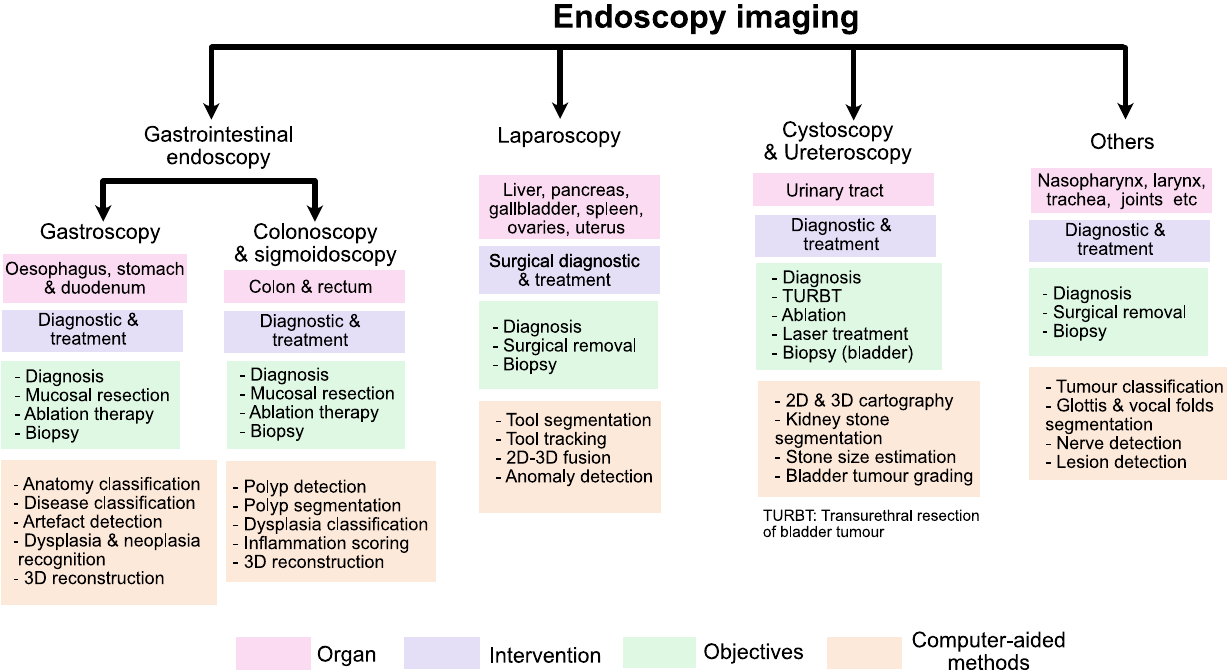
Fig. 1 Overview of endoscopic image analysis for surveillance and surgical procedures in the human body. Widely used endoscopic procedures are presented in separate unique categories and subcategories while the rest of the procedures are provided under others. Each is divided into organ of interest, intervention type, objectives and computer-aided methods that are being developed to address some of the objectives presented in these endoscopic